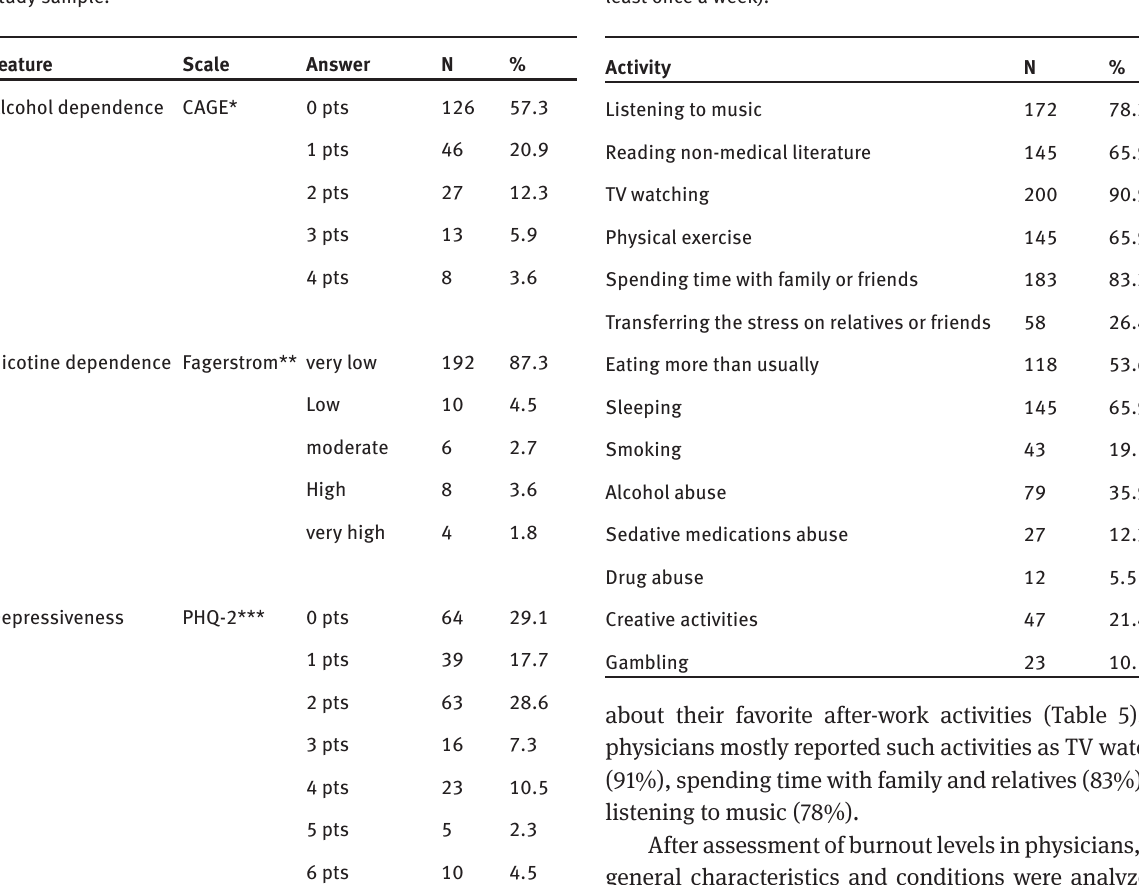
Table 4: Prevalence of negative health conditions and behaviors in study sample.